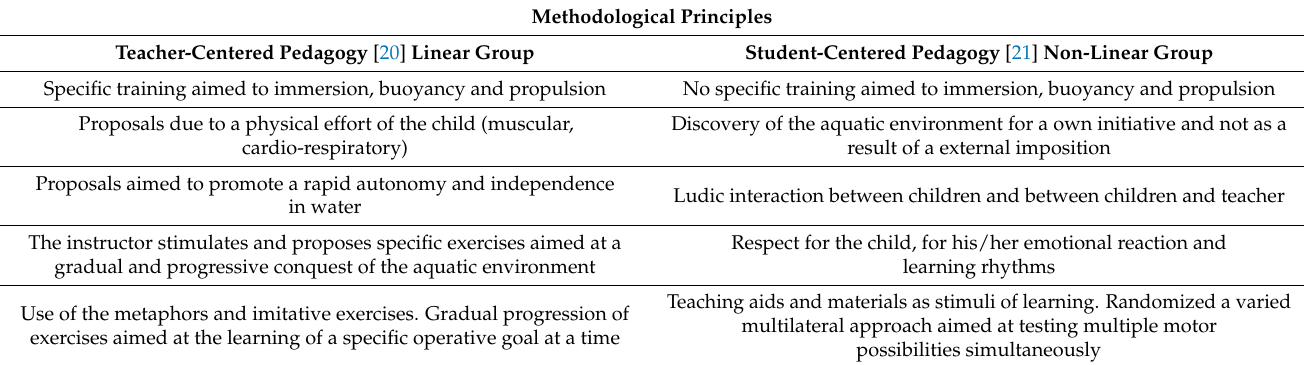
Table 1. Comparison of the main methodological principles regarding teacher-centered (LI) and student-centered (NL)